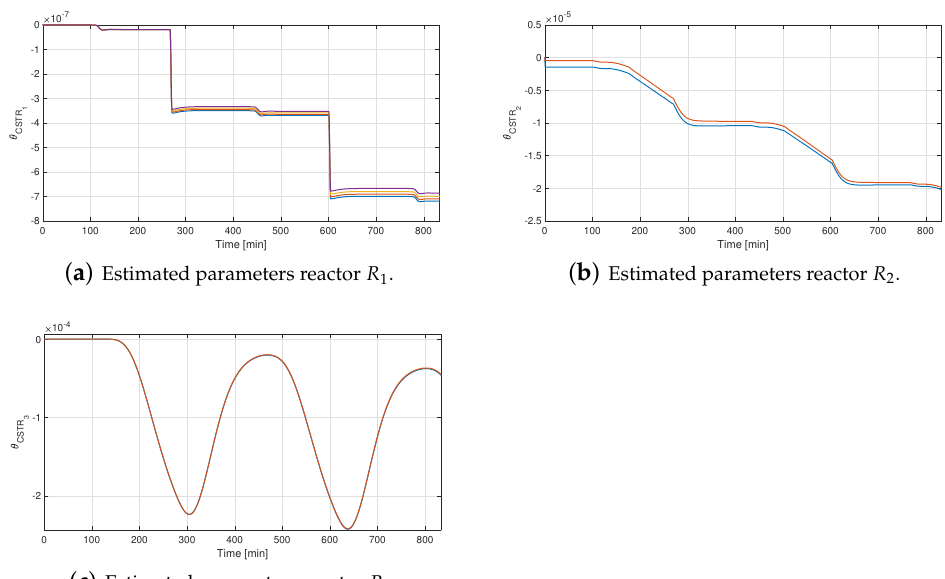
Figure 12. Performance of adaptive controller under an abrupt change in temperature in reactor R 1 —parameter